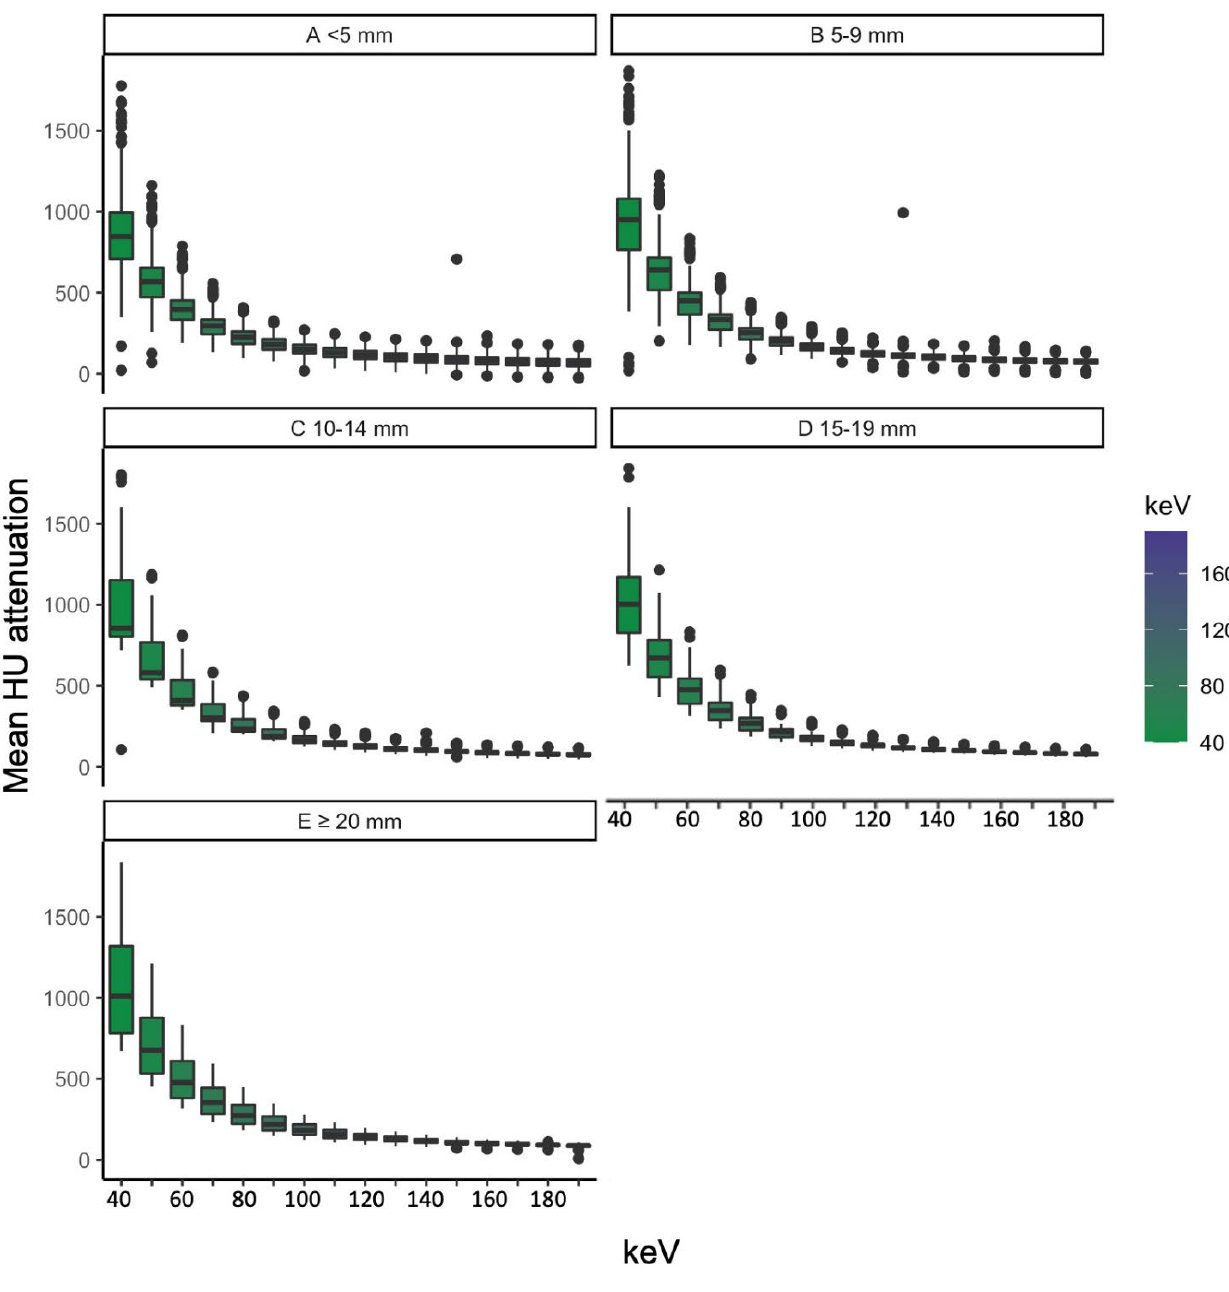
Figure 5. Attenuation grouped by vessel diameter (( A ) for less than 5 mm, ( B ) for 5–9 mm, ( C ) for 19–14 mm, ( D ) for 15–19 mm and ( E ) for more than 20 mm) dependent on energy